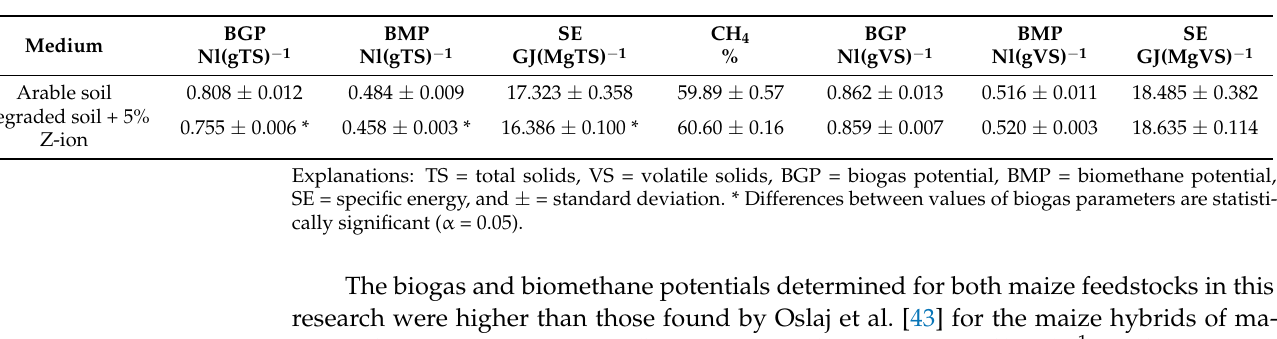
Table 6. Biogas and biomethane potential and specific energy of maize